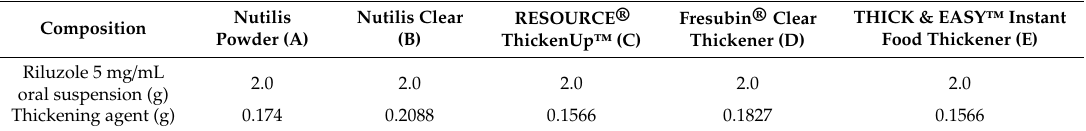
Table 2. Compositions of Riluzole 5 mg / mL oral suspension-thickener